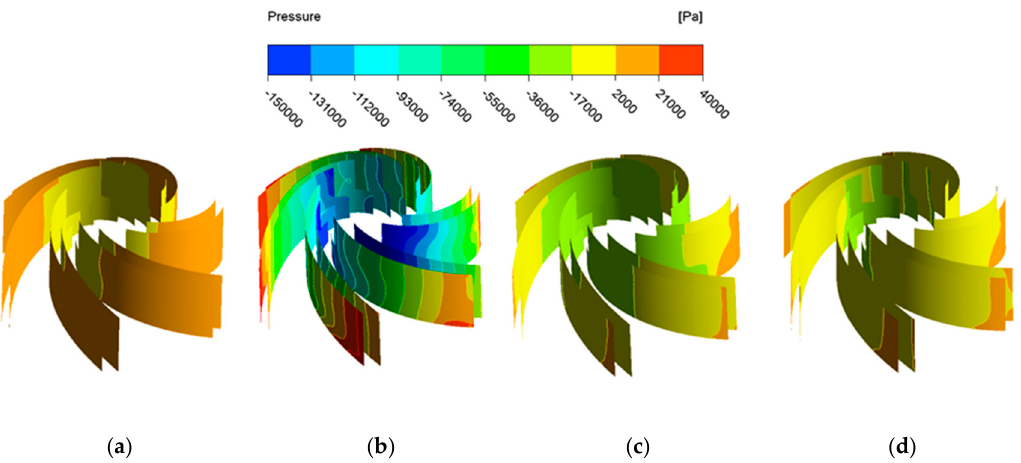
Figure 14. Pressure distribution of blades with variable speed: ( a ) t = 0.05 s; ( b ) t = 0.16 s; ( c ). t = 0.35 s; ( d ) t = 0.5 s.